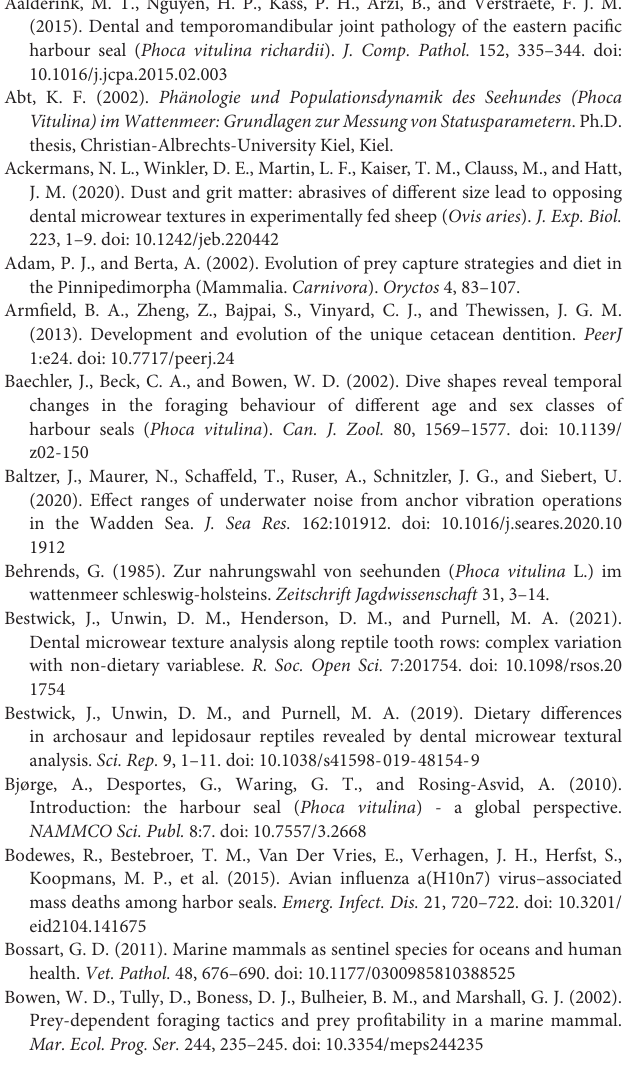
postcanine teeth; PC4, fourth postcanine teeth; n , number of specimens; n sp , number of significant parameters. For descriptions of microwear texture parameter, see Table 2 . Supplementary Table 4 | Raw dental microwear data for all 242 measured teeth. phvit, Phoca vitulina ; ZIK, Zoological Institute of Kiel University, Germany; I3, third incisor teeth; C, canine teeth; PC2, second postcanine teeth; PC3, third postcanine teeth; PC4, fourth postcanine teeth; n Scans, number of valid scans included in analysis; Total length [mm], Weight [g]; For descriptions of parameters, see Table 2 . Surface texture files are stored at the database of the public natural history museum (University of Hamburg, Center of Natural History Hamburg, mammal collection) and can be accessed via the open source data repository of the University of Hamburg (doi: 10.25592/uhhfdm.8979). texture files as conducted in established protocols (Schulz et al., 2013, 2010). The template is accessible through the open-source data repository